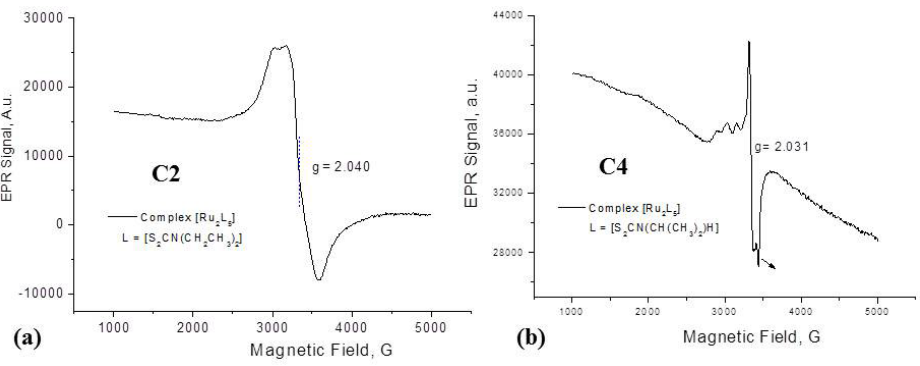
Figure 2. EPR spectra registered in solid state, at 77K, for complexes ( a) C2 ( α -pentakis( N , N